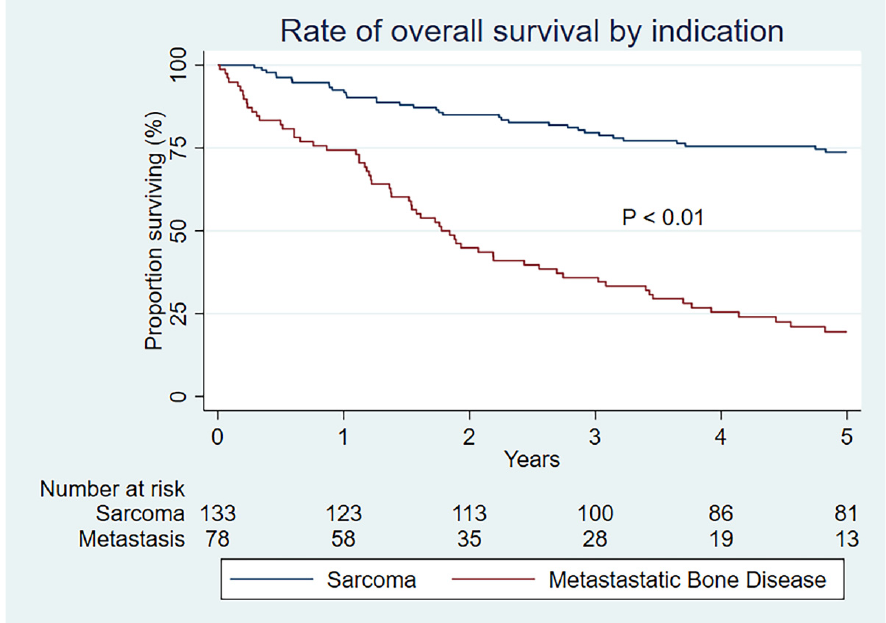
Figure 2. Cumulative incidence of risk of revision by competing risk model (death as competing risk) by indication.